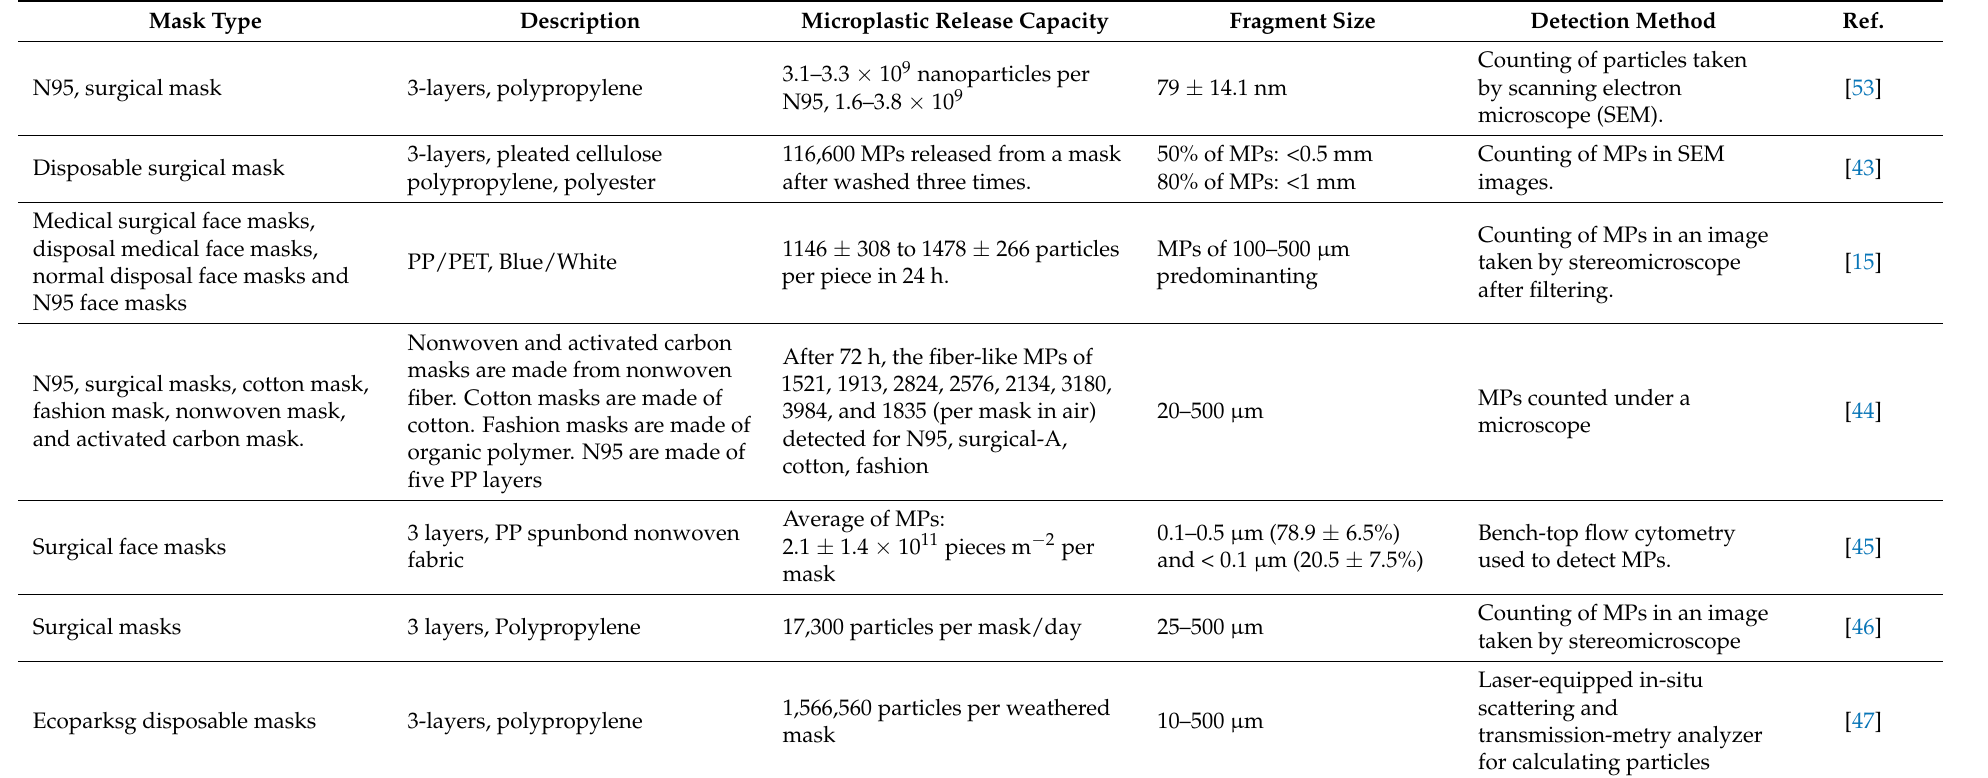
Table 1. The release capacity, size and existing detection methods of mask